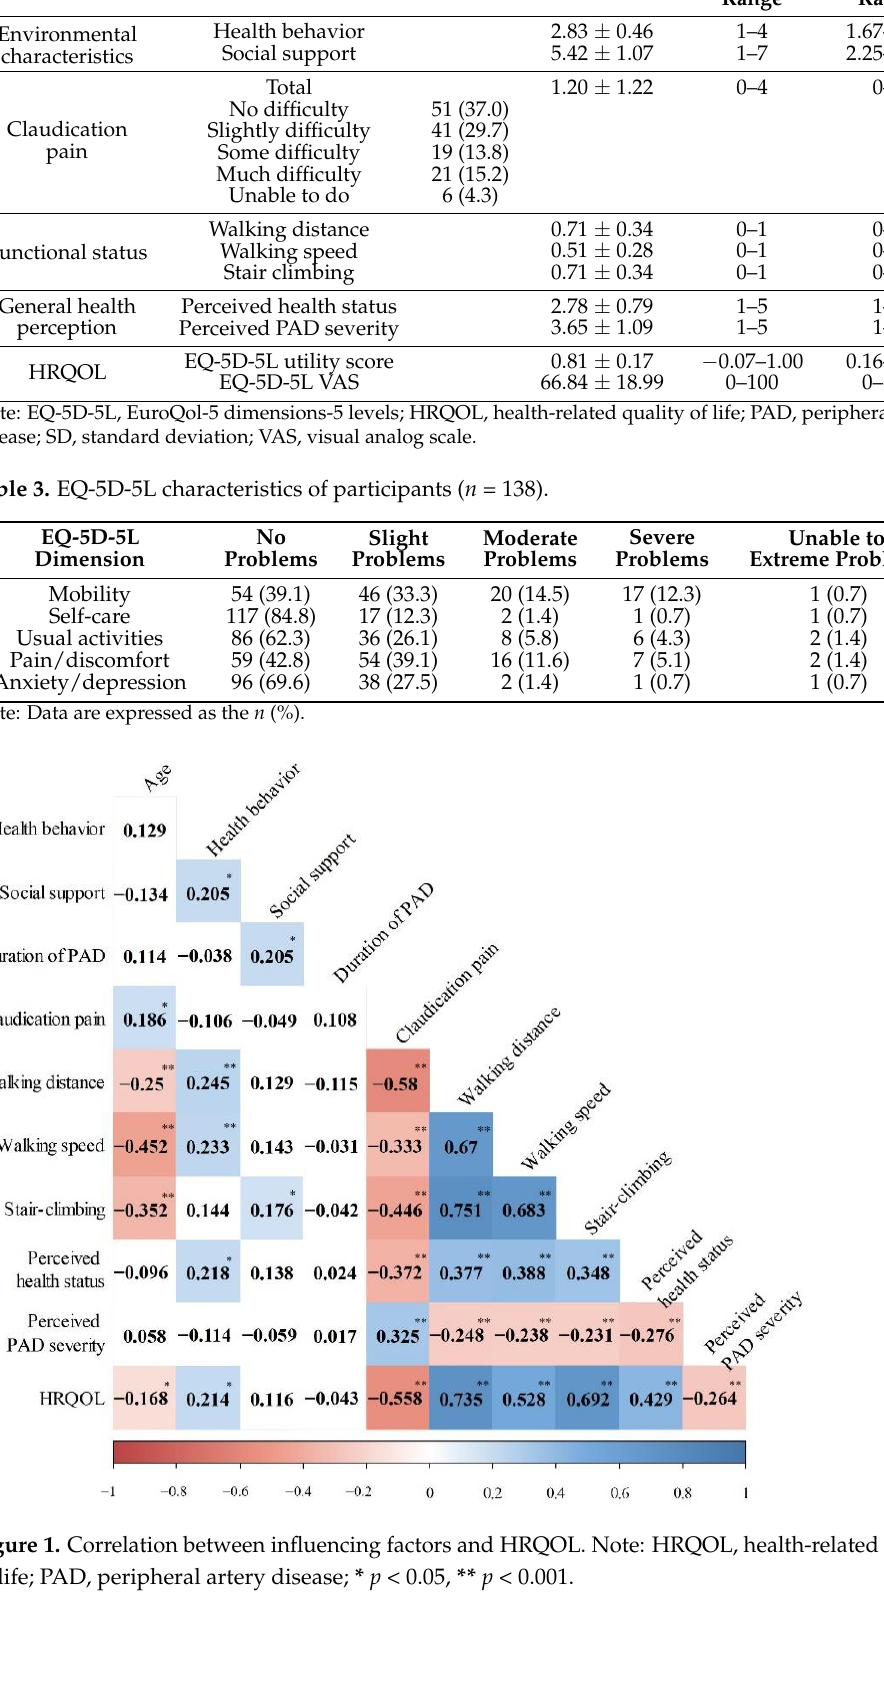
Table 3. EQ-5D-5L characteristics of participants ( n = 138).